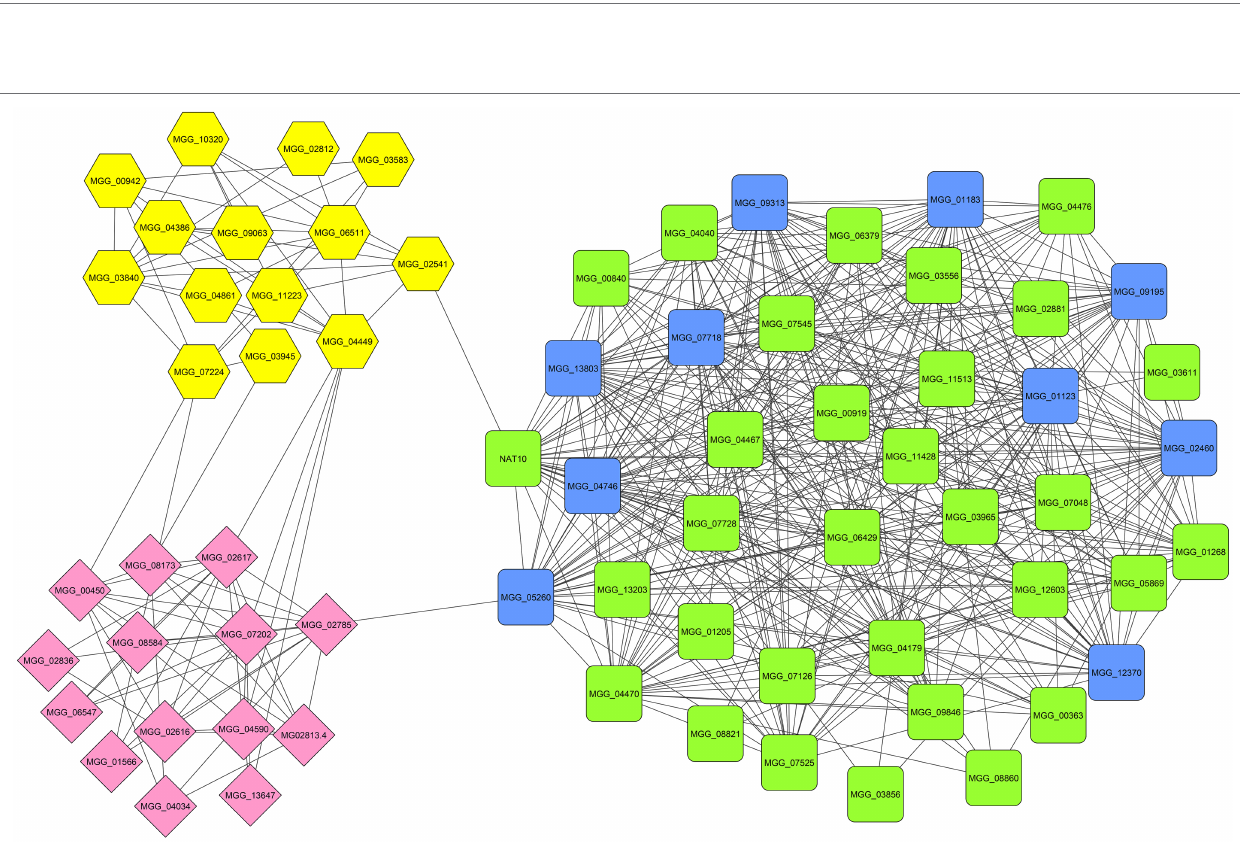
FIGURE 5 | The significant modules (blue and red) and identified hub genes (purple) associated with up-regulated DEGs of M. grisea fungi in response to ZnO NPs.